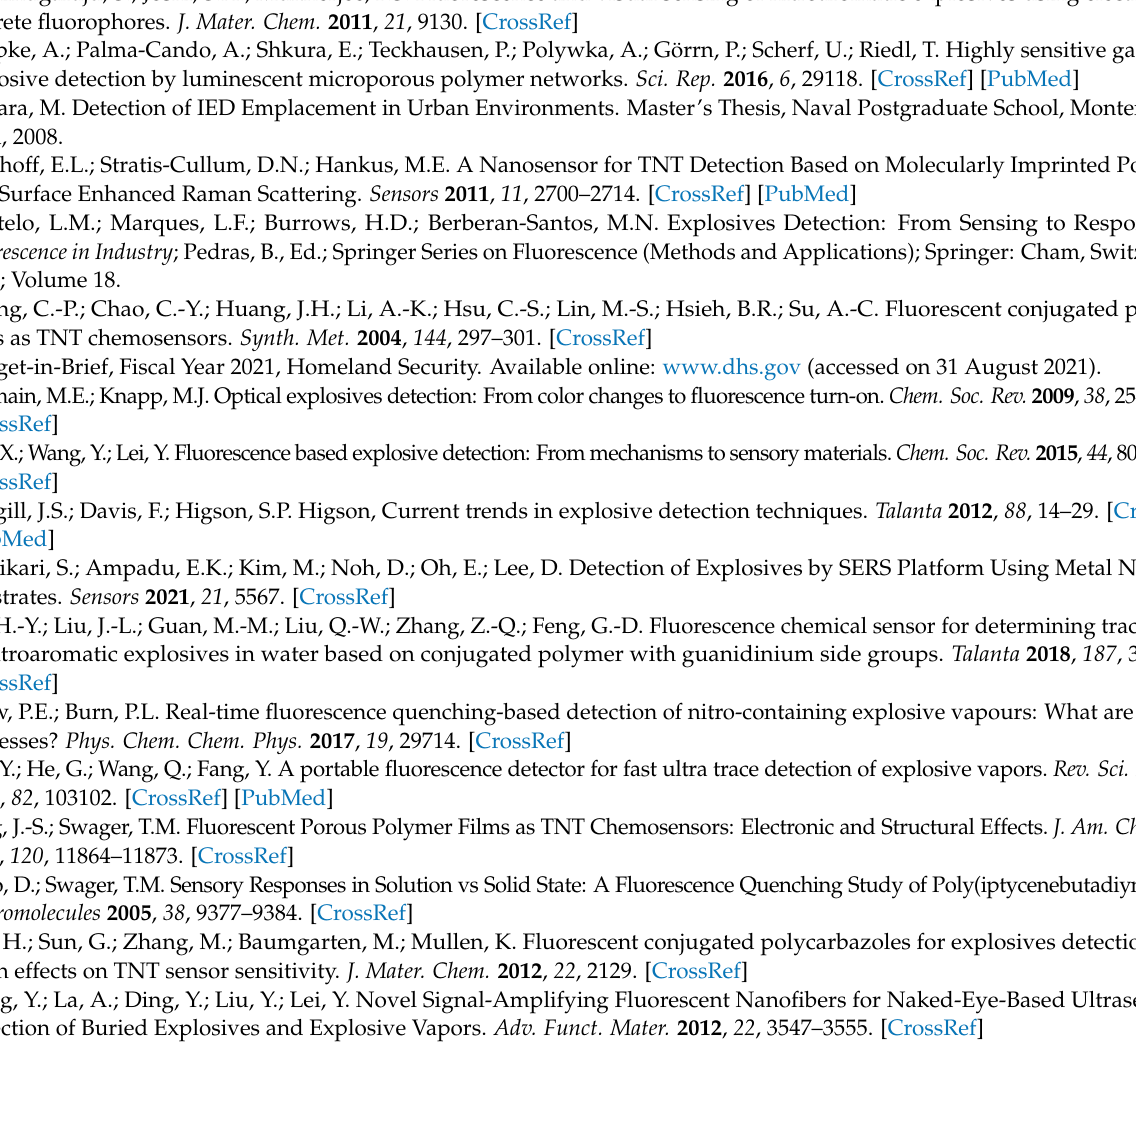
tary Figure S1: Supplementary Figure 1.png; Supplementary Figure S2: Supplementary Figure